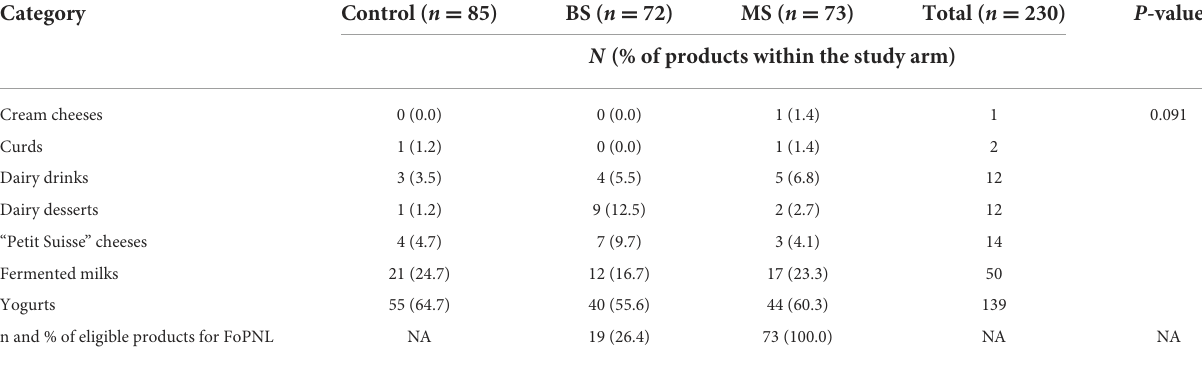
TABLE 4 Number and percentage of scans, grouped by category and study arm.